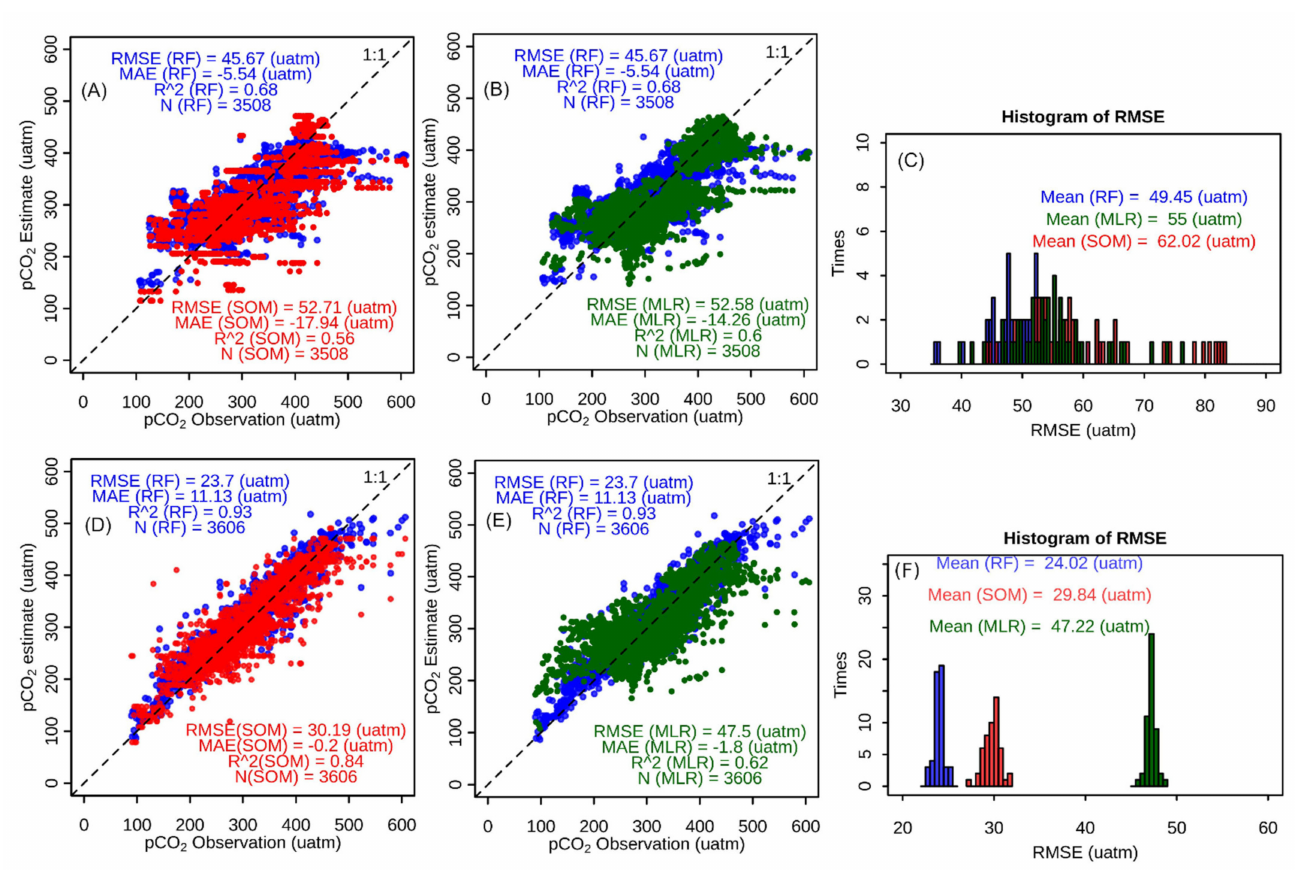
Figure 8. Comparison of random forest, SOM, and multiple linear regression (MLR) in pCO 2 estimation in the Baltic Sea. ( A , B ) Comparison of a random forest model (i.e., RF in the figures) to the SOM model and MLR model trained with exactly the same in-situ data from 2/3 of months selected randomly; ( C ) Histograms of RMSE of 50 models trained in the same manner as in A and B; ( D , E ) Comparison of a random forest model to the SOM model and MLR model trained with exactly the same 2/3 of the in-situ data selected randomly; ( F ) Histograms of RMSE of 50 models constructed the same manner as in ( D , E